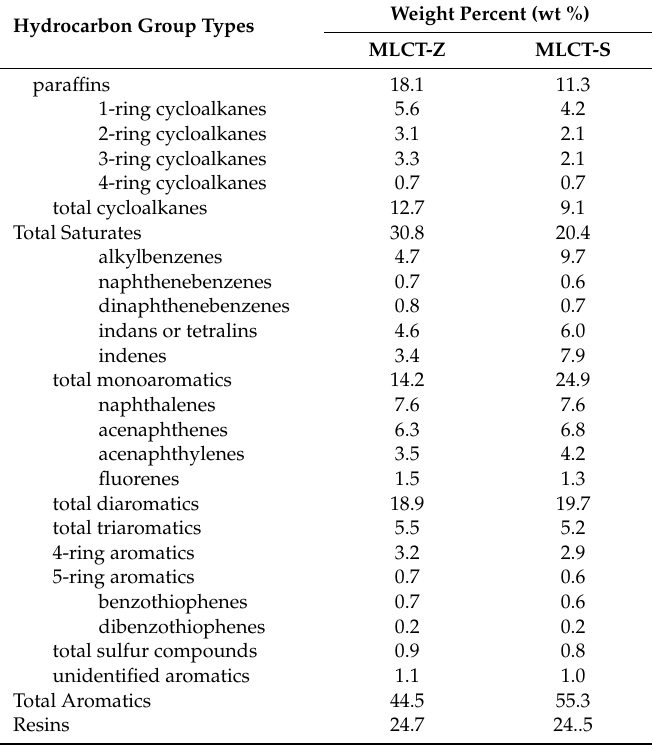
Table 2. Hydrocarbon type analysis of the